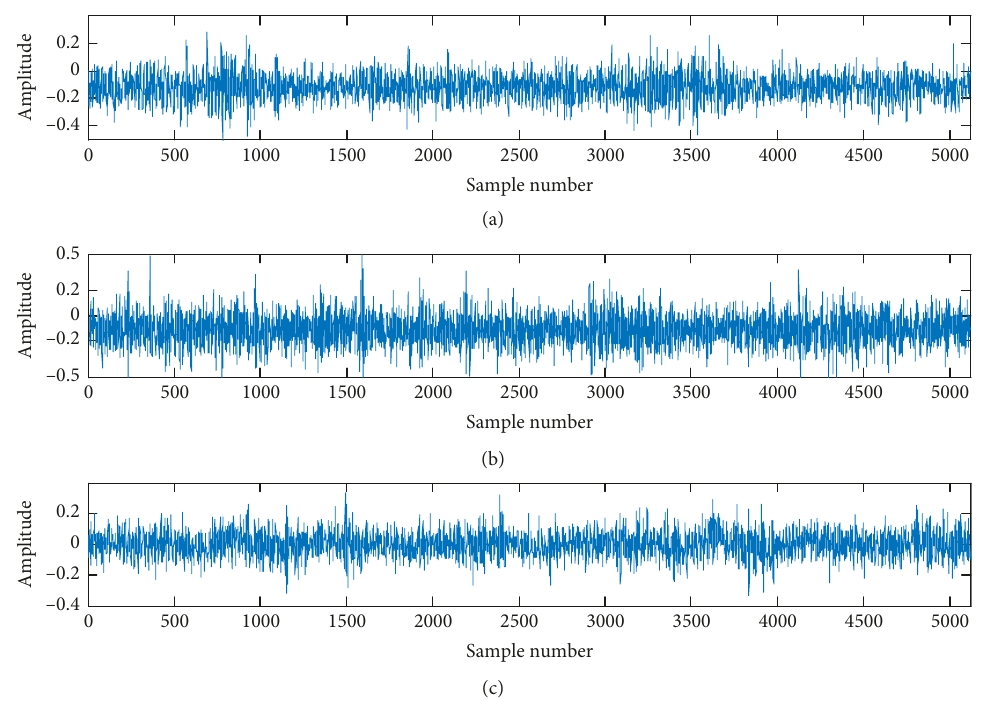
Figure 15: The time domain diagram of the training signals, where (a), (b), and (c) represent normal bearing signal, inner race fault signal, and outer race fault signal come from the snapshots 2003.10.31.08.59.46, 2003.11.22.11.06.56, and 2004.02.15.10.32.39, respectively. Each signal is listed with the sample number 5120.